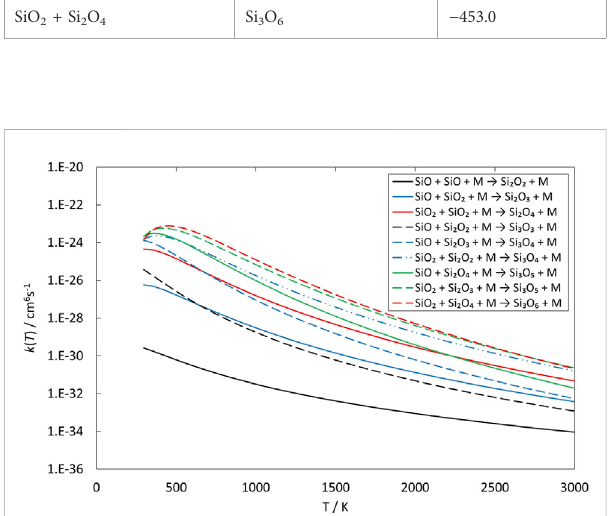
FIGURE 13 Ratecoef fi cients( fi ttoRRKMcalculations)ofclusteringreactions of small silicon oxide molecules as a function of temperature.